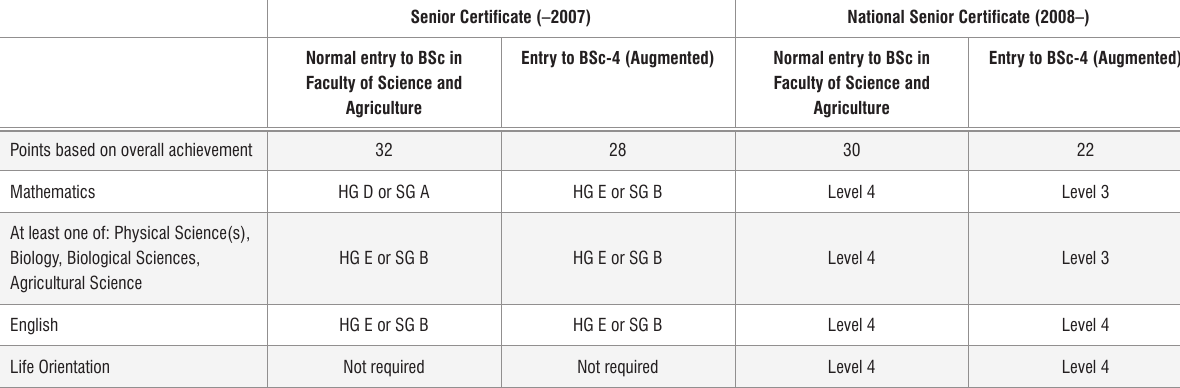
Comparison of entry requirements for BSc and BSc-4 (Augmented) degrees at the University of KwaZulu-Natal Senior Certificate